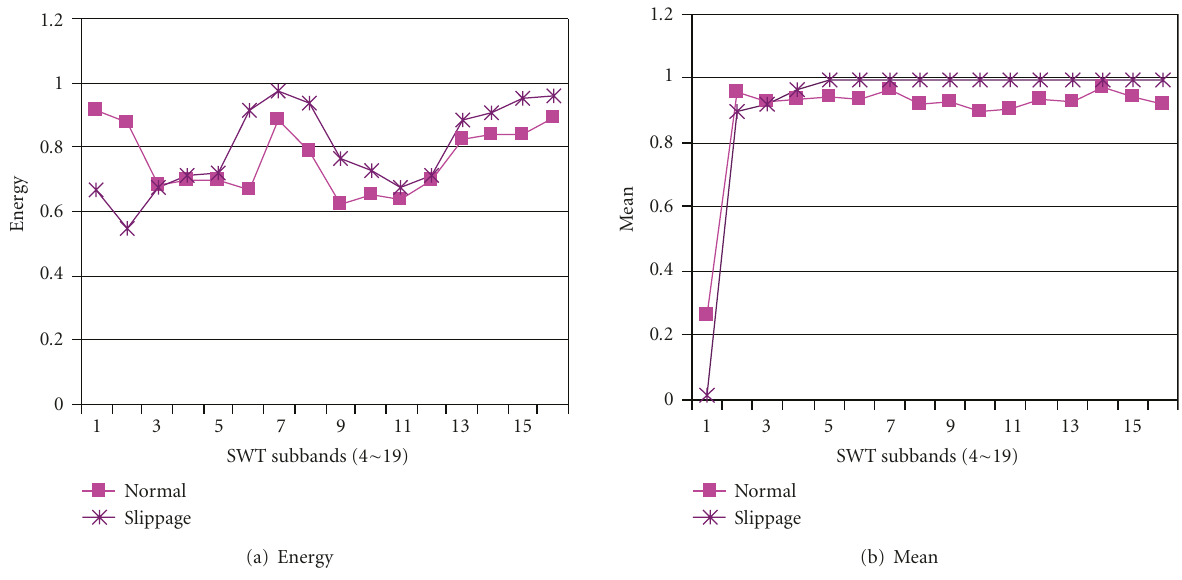
Figure 7: Normalized feature values for Figures 6(b) and